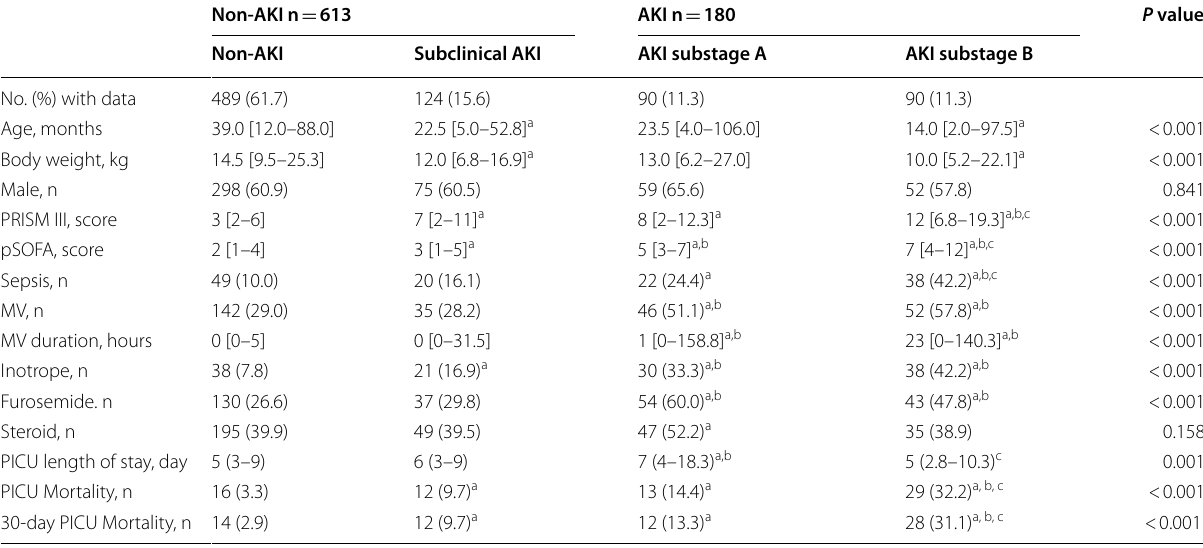
Table 1 Comparison of demographic and clinical characteristics among groups